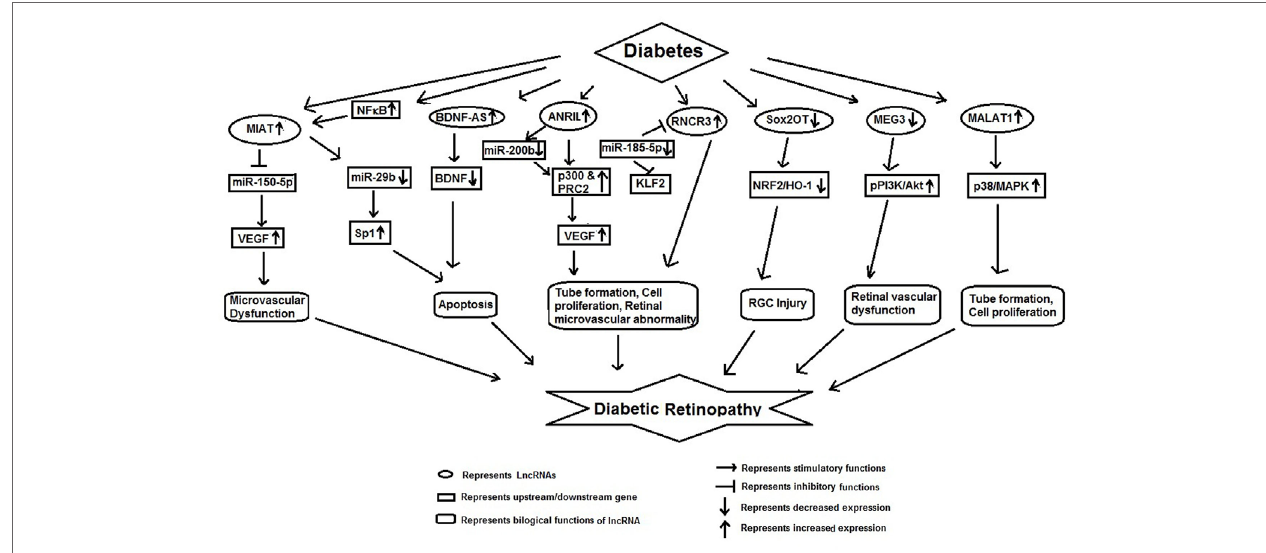
FiGURe 2 | Schematic model showing functional role of long non-coding RNAs in diabetic